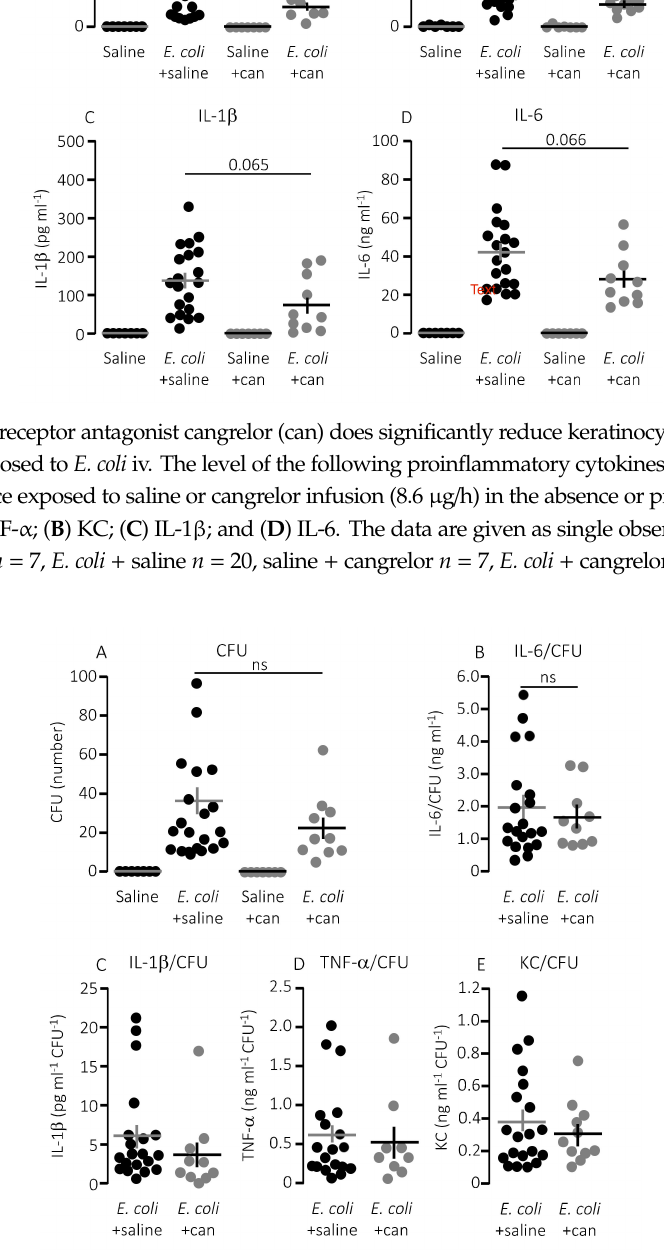
Figure 7. The cytokine-response relative to the degree of infection inflicted by injection of HlyA-producing E. coli in the absence or presence of infusion of P2Y 12 receptor antagonist. ( A ) The number of colony forming units (CFU) from streaking out 5 µ L whole blood of mice infused with control solution or cangrelor (8.6 µ g / h) either after exposure to HlyA-producing E. coli or saline solution. ( B – E ) The cytokine [( B ) IL-6; ( C ) IL-1 β ; ( D ) TNF- α ; and ( E ) KC] response relative to the infection status represented by the number of CFU. The data are given as single observations and mean ± S.E.M (saline n = 7, E. coli + saline n = 20, saline + cangrelor n = 7, E. coli + cangrelor (8.6 µ g / h) n =